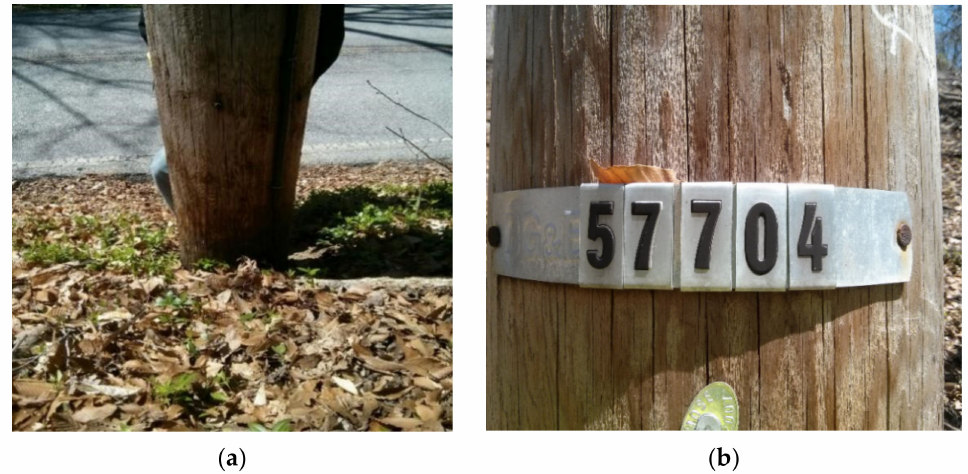
Figure 5. Tested wooden utility pole labeled as 57704: ( a ) its embedment condition and ( b ) its label.